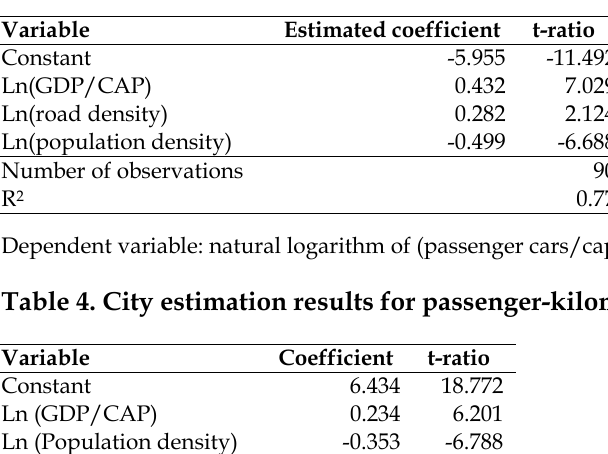
Table 3. City estimation results for motorisation